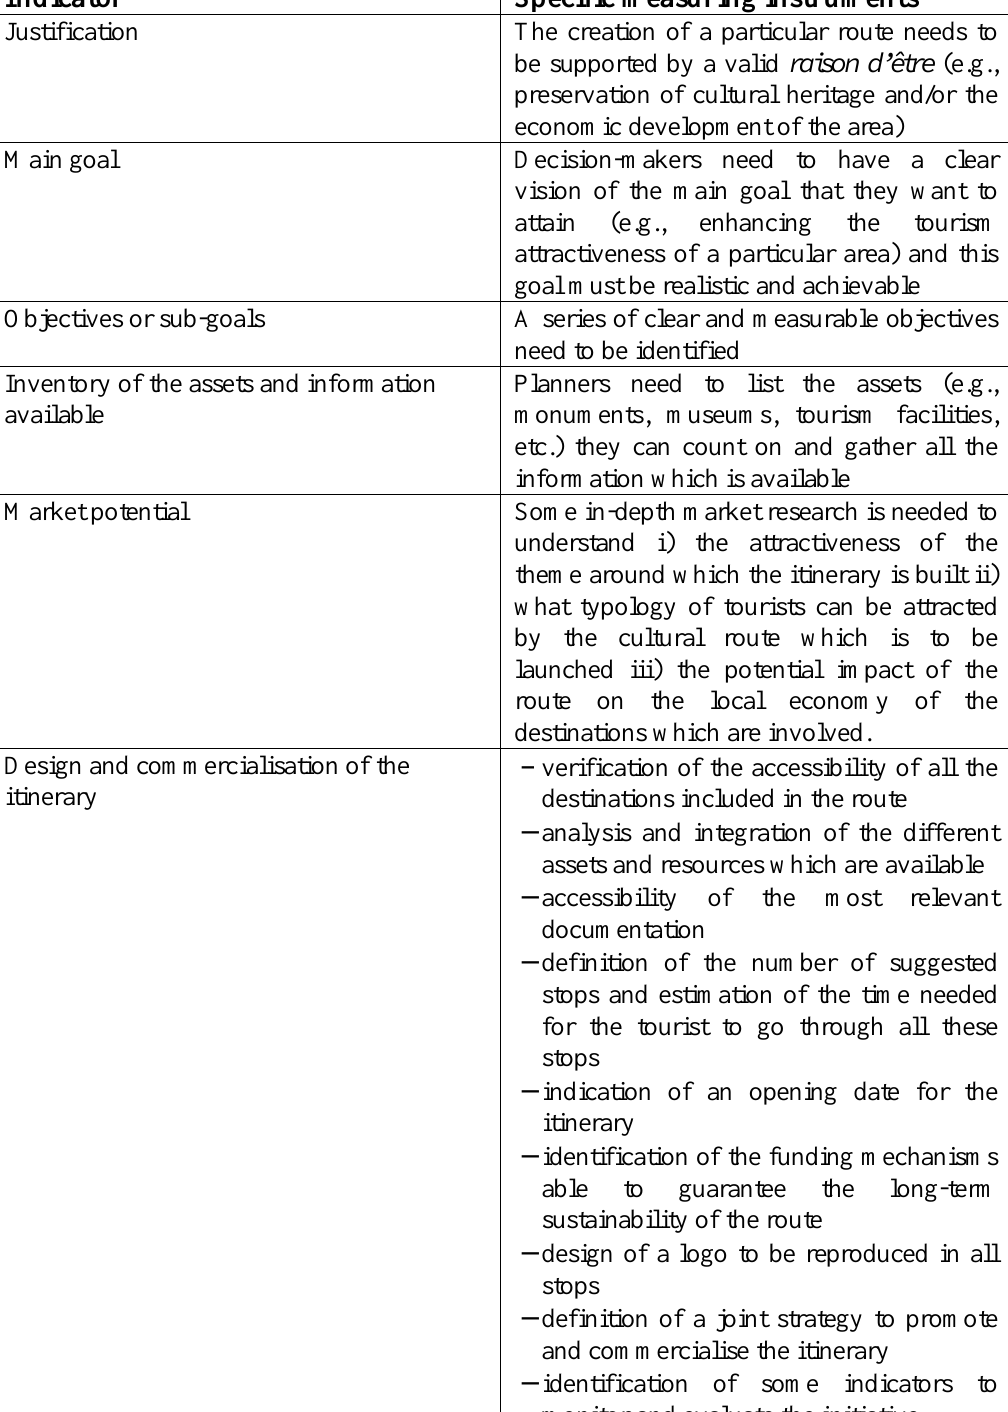
Table 1 : Elements to Take into Account in the Development of a Cultural Route